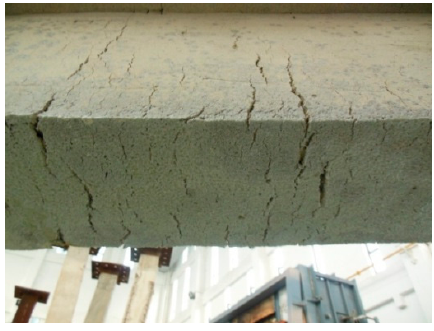
Figure 10. Typical surface of fire insulation after the fire test.